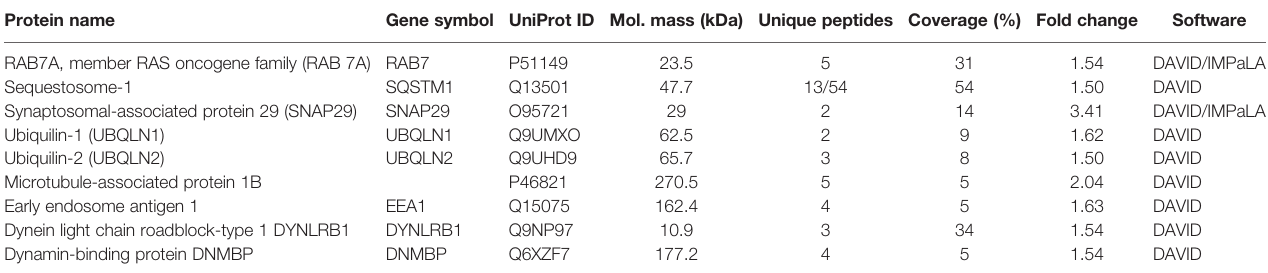
TABLE 3 | List of proteins associated with autophagy and retrograde transport, identi fi ed to be upregulated in B*2704-transfected cells. Protein name